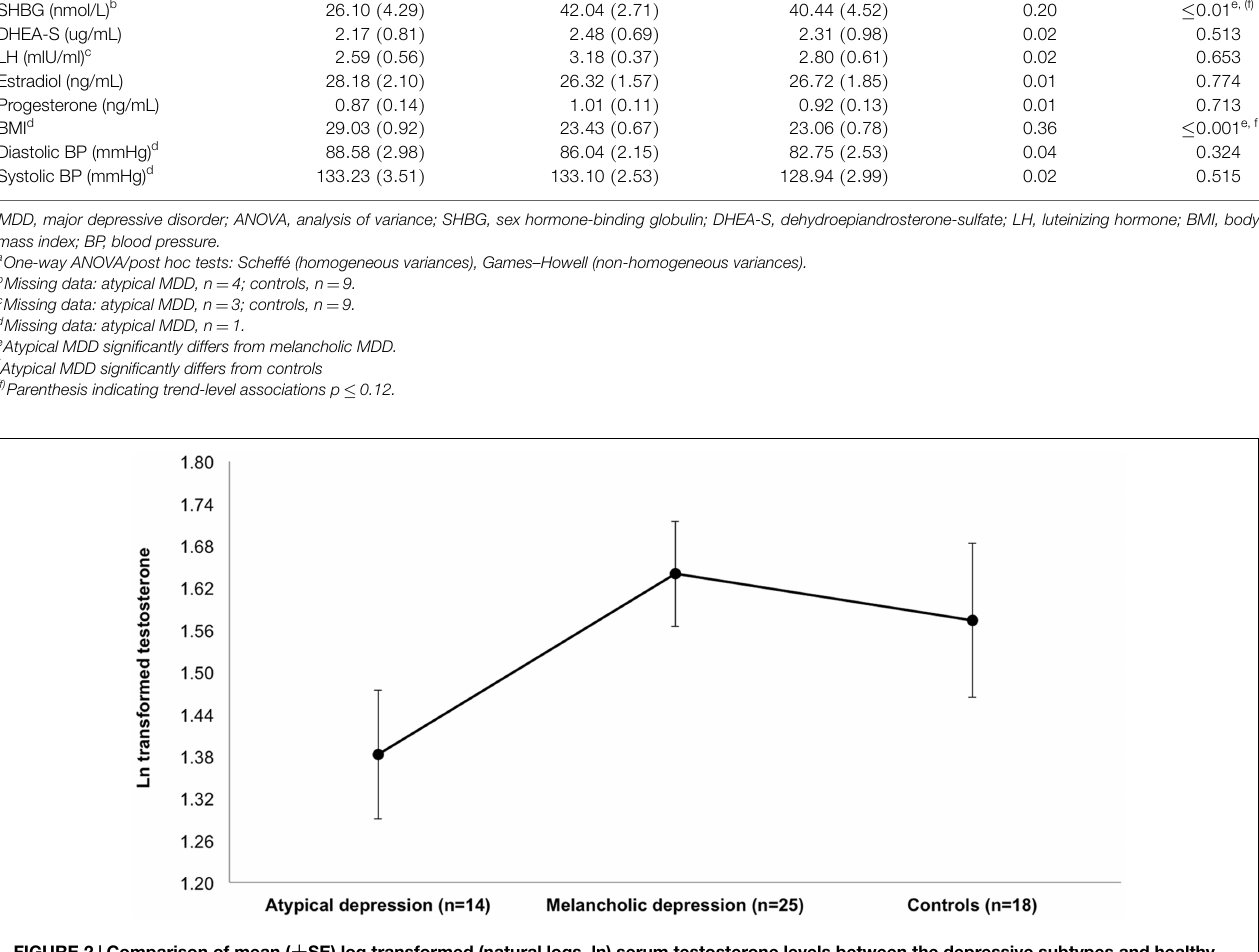
FIGURE 2 | Comparison of mean ( (cid:6) SE) log transformed (natural logs, ln) serum testosterone levels between the depressive subtypes and healthy controls after adjustment for age, smoking, alcohol abuse, and psychopharmacological medication